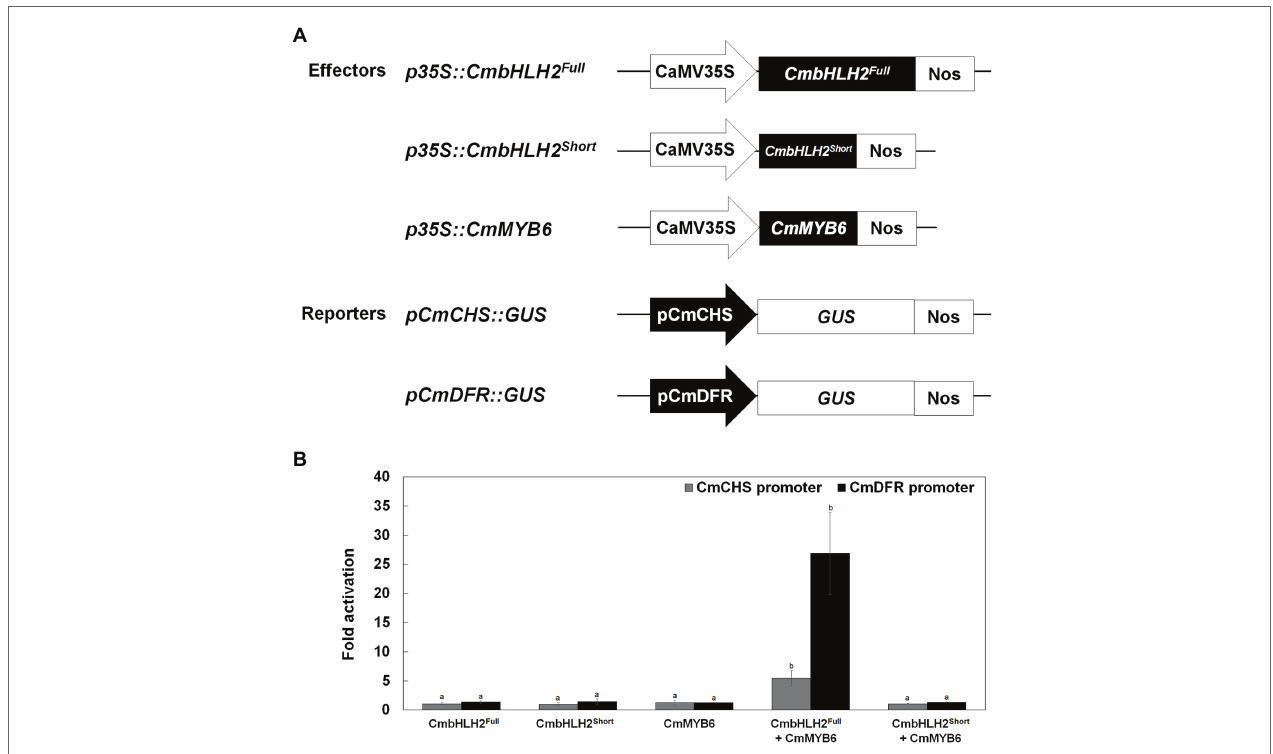
FIGURE 7 | Transcriptional activation assay of the roles of CmbHLH2 Full , CmbHLH2 Short , and CmMYB6 in activating the CmCHS and CmDFR promoters. (A) Effector and reporter constructs used in the transcriptional activation assay. The effector construct contained CmMYB6 , CmbHLH2 Full , and CmbHLH2 Short driven by the CaMV 35S promoter. The reporter constructs contained the GUS reporter gene driven by the CmCHS and CmDFR promoters. (B) The effects of regulatory proteins CmbHLH2 Full , CmbHLH2 Short , and CmMYB6 on CmCHS and CmDFR promoter activity. Results represent mean values ± SD from three biological replicates. Different letters above the bars indicate significantly different values ( p < 0.0001) calculated using one-way ANOVA followed by Duncan’s multiple range